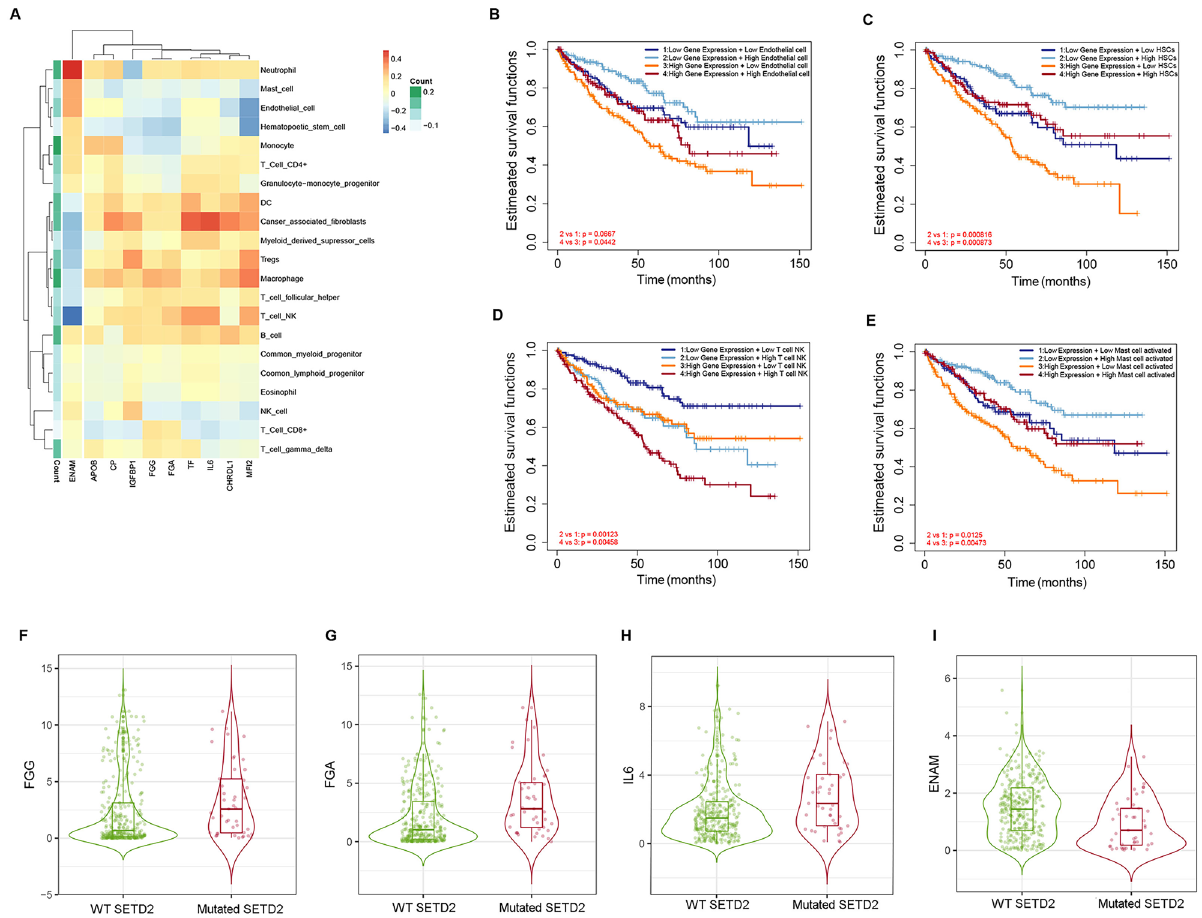
Figure 6. Association of the expression of the cluster 2 gene hub and the TME. The heat map shows the correlation coefficients of expression for 10 hubs of genes with the level of infiltration of immune cells in ccRCC ( A ). Cell color changes from blue to red depending on the Spearman’s correlation coefficient. Clustering distance method was performed for rows by Pearson correlation. Survival curves for hub genes associated with levels of endothelial cell infiltration ( B ), hematopoietic stem cells ( C ), NK T cells ( D ) and mast cells ( E ). Correlation of the expression of FGG ( F ), FGA ( G ), IL6 ( H ), and ENAM ( I ) with mutations in the SETD2 gene ( P <